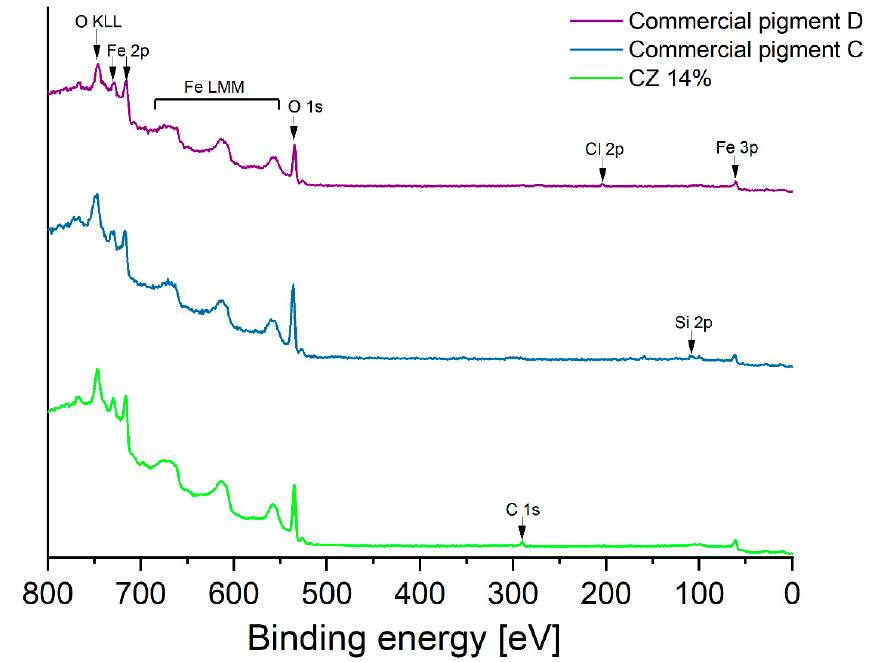
Figure 6. The survey XPS spectra of CZ 14% and Commercial pigments C and D.